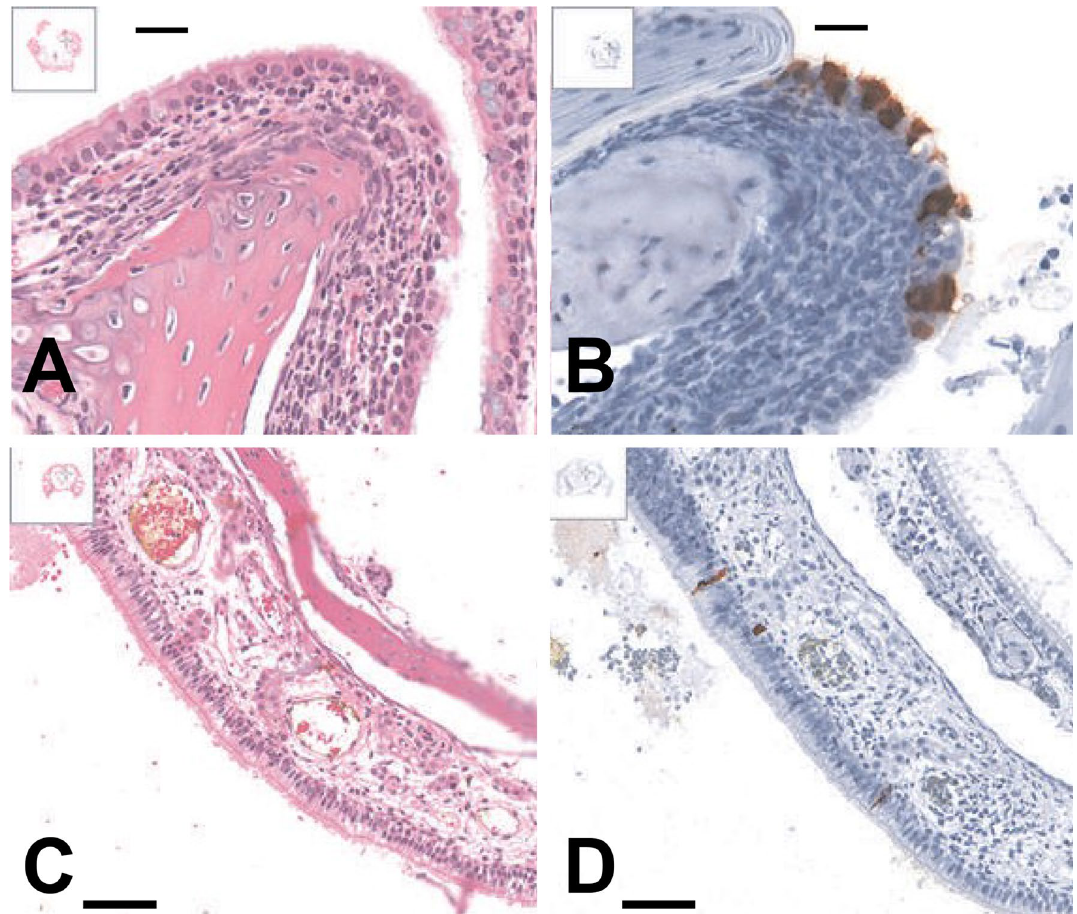
Figure 5. Positive SARS-CoV-2 antigen labeling was not associated with a specific inflammatory response in the nasal respiratory epithelium. ( A , B ) show nasal turbinates from a ferret euthanased at day 3 post-inoculation (p.i.) with moderate infiltration of neutrophils and lymphocytes in an antigen-positive region of the respiratory epithelium. Tissues from a ferret humanely killed at 7 days p.i., ( C , D ) show an antigen-positive region of the respiratory epithelium, not associated with an inflammatory infiltrate. Panels ( A , C ) represent H&E stained sections. Panels ( B , D ) represent the corresponding SARS-CoV-2 IHC sections labelled with a nucleocapsid- specific polyclonal antibody, HRP-secondary antibody and aminoethyl carbazole chromagen. Scale bars in each panel represent 50 of SARS-Cov-2 in ferrets 21 days post-infection, with a low neutralizing antibody response detected in two of four ferrets 34 . Even though COVID-19 patients typically present with signs of respiratory disease, several case studies have reported gastrointestinal symptoms and/or evidence that some patients have viral RNA or live infectious virus in the feces 41 . The fecal–oral route of transmission of SARS-CoV-2 is yet to be confirmed 42 ; however, in this study, viral RNA was distributed throughout the GI tract, involving the stomach, duodenum, jejunum, ileum and colon in both male and female ferrets between day 3 and 7 p.i. after intranasal administration of the VIC01 strain. Given that ferrets that had qRT-PCR positive rectal swabs also had positive nasal wash samples and/or oral swabs, the detection of viral RNA in the GI tract may be due to the swallowing of viral particles from the upper respiratory tract. Other possibilities may be the detection of remnants of infected submucosal intestinal antigen-presenting immune cells or that there is active virus replication in intestinal cells, although viral antigen was not detected in the intestine by IHC. This suggests that if active viral replication was present in the intestine, it was minimal below the level of detection by IHC and virus isolation. The blood biochemistry and hematology results observed in this ferret model aligned with some changes observed in COVID-19 patients, for example, increases in aspartate aminotransferase (AST) and glucose were observed in 35% and 52% of patients admitted with SARS-CoV-2 pneumonia 43 . However, ferrets in this study exhibited only a mild clinical course, and the mechanism behind these parameter changes may not necessarily mimic that in the human disease course. Furthermore, the inherent variation in the level of stress experienced by the different ferrets, and the use of sedatives, such as xylazine and ketamine, known to produce hyperglycemia 44,45 , may offer alternative explanations to the observed changes in serum glucose. The mechanism behind the AST elevation is also undetermined, but individual variation (including sample collection variation causing hemolysis)